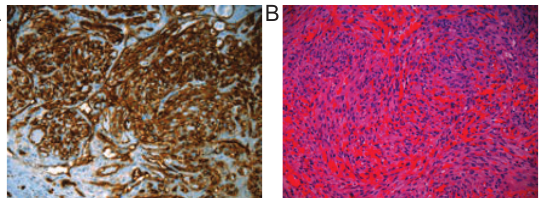
Figure 2. A skin rash (A, B and C) in the legs before treatment.